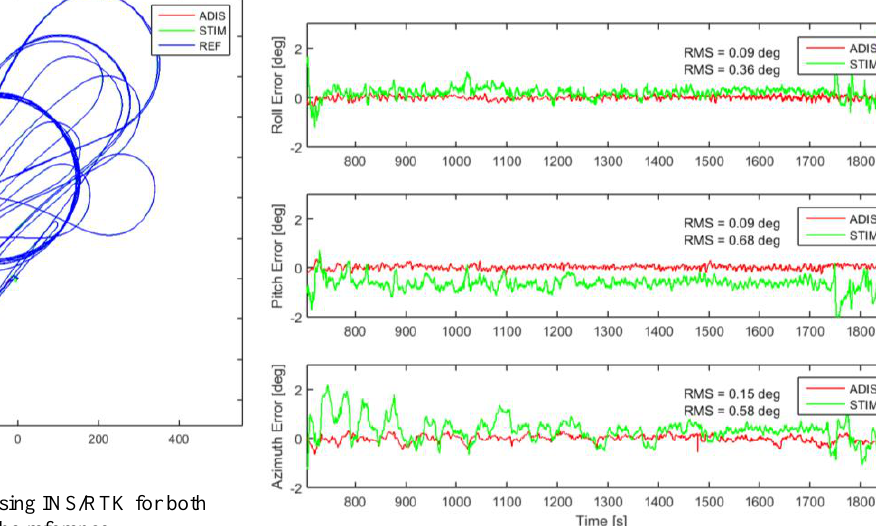
Figure 7. Position error in East, North, and Down for both IMUs